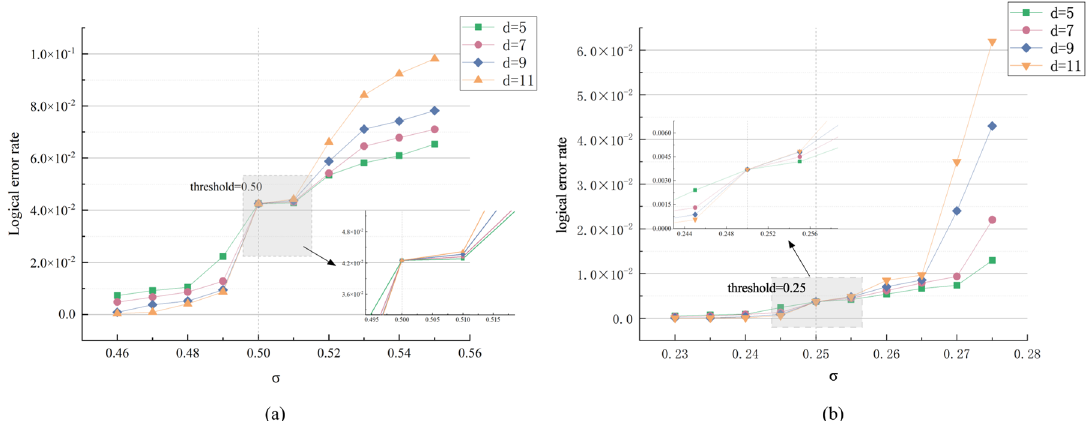
Fig. 6 Schematic diagram of threshold value under MWPM decoder. a The left picture is the rendering of MWPM decoder for the fi rst error type, in which the green square, purple circle, blue diamond, and yellow triangle represent surface-GKP codes with code distances of 5, 7, 9, and 11, respectively. The σ represents the standard deviation of the stea error correction scheme, which is also expressed as the physical error rate by the Gaussian noise random channel. b The threshold in this fi gure can be seen from the right panel to be 0.50, and the right image is for the stabilizer measurement. Thresholding effect of the second error type MWPM decoder combined with Dijkstra ’ s algorithm, it can be clearly seen that the threshold is much lower at